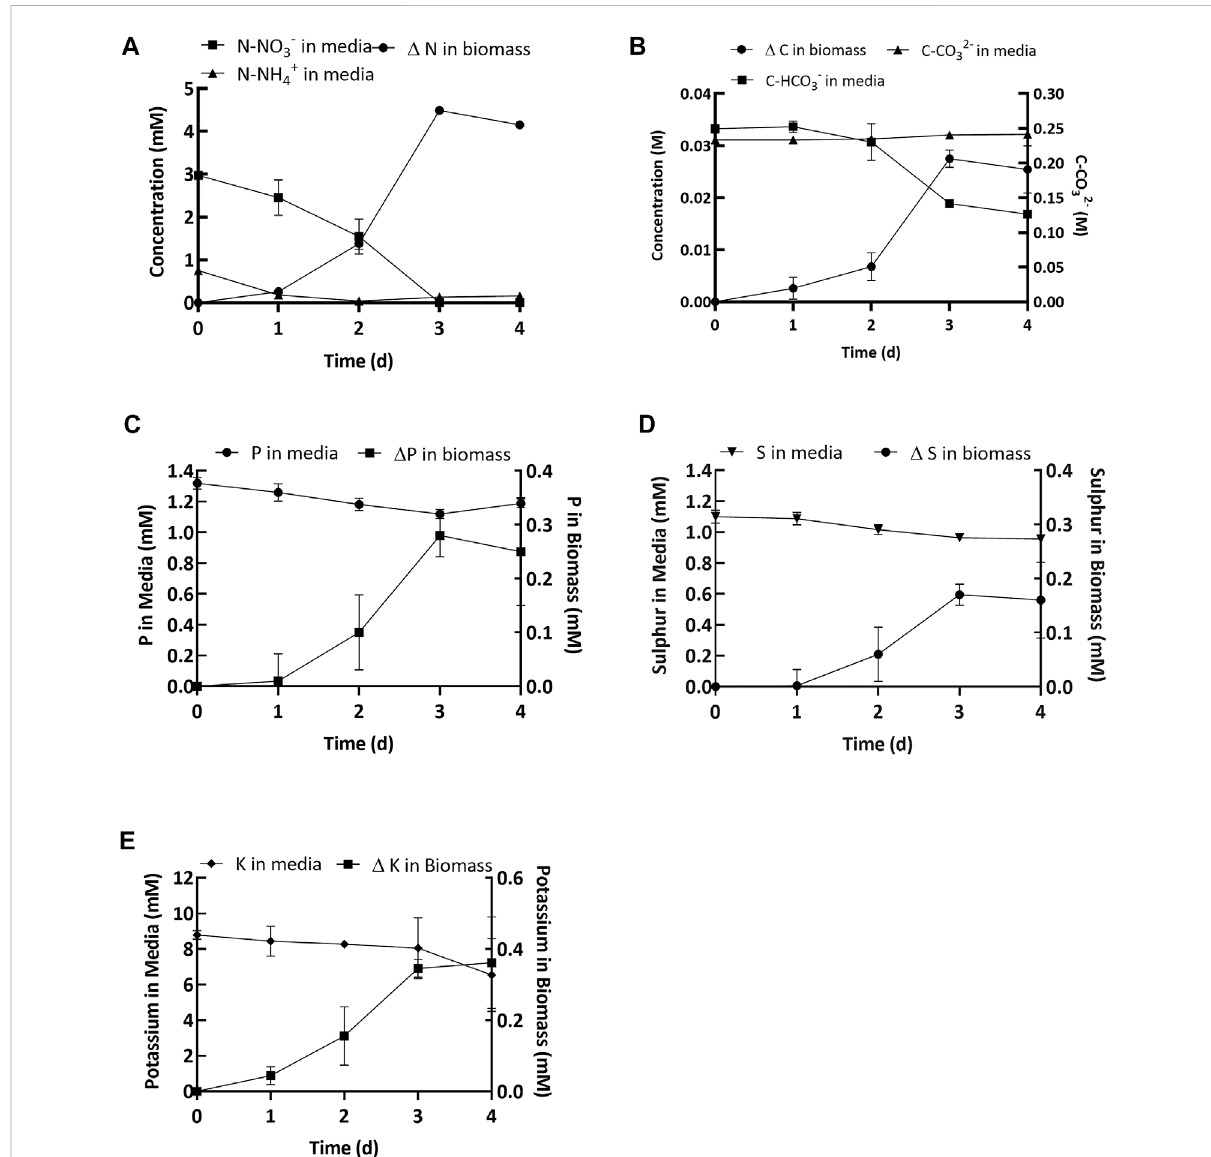
FIGURE 4 (A) Solublenitrogen(NH 4 + andNO 3 − )depletedinthemediaandchangeinbiomass. (B) Bicarbonate (squares,left y -axis)andcarbonate(circles, left y -axis)concentrationinthemediaandchangeincarboninthebiomass(mM)(triangles,right y -axis). (C – E) Concentrationofelements(P,SandK) in the spent media and change in the biomass. Values shown in the graphs are averages based on three replicates and error bars represent the standard deviation of the triplicate samples for each time